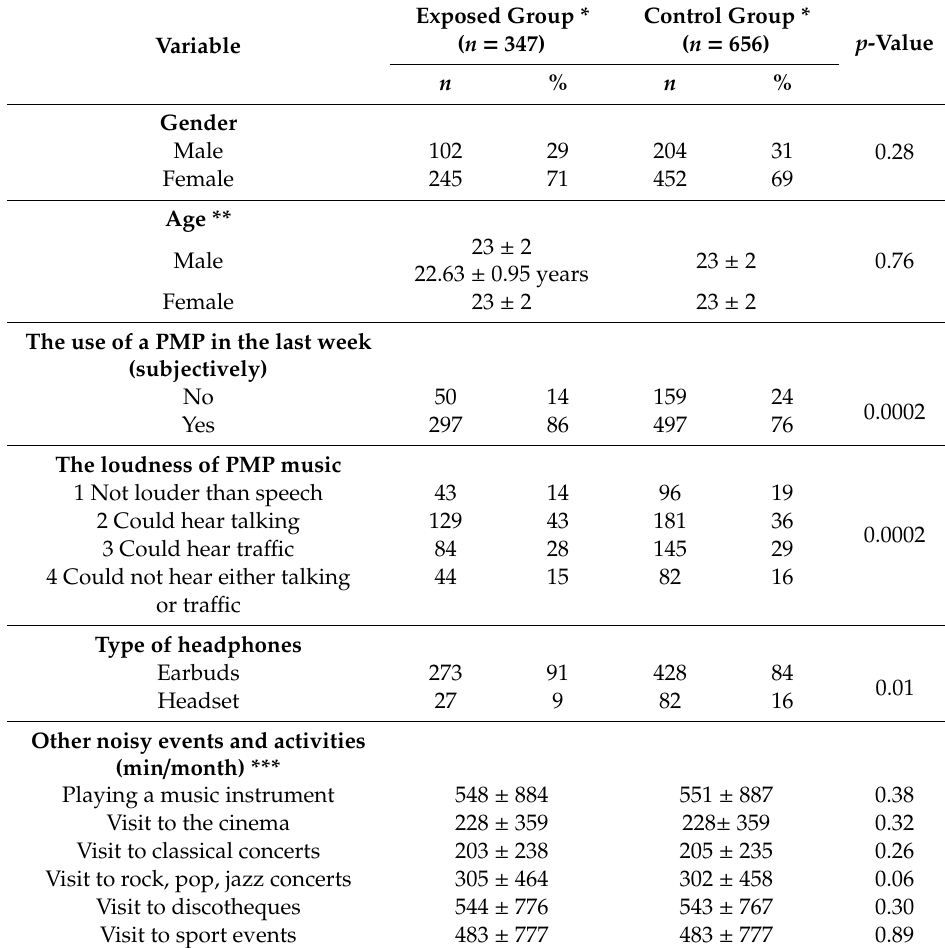
Table 1. Characteristics of the students’